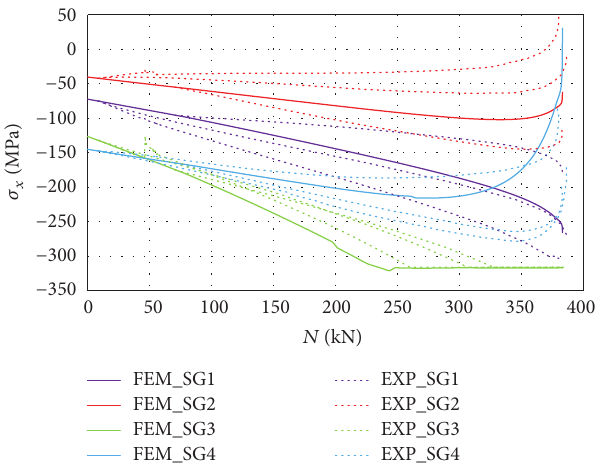
Figure 10: Longitudinal stresses on strain gauges during loading, comparison of numerical model and experimental